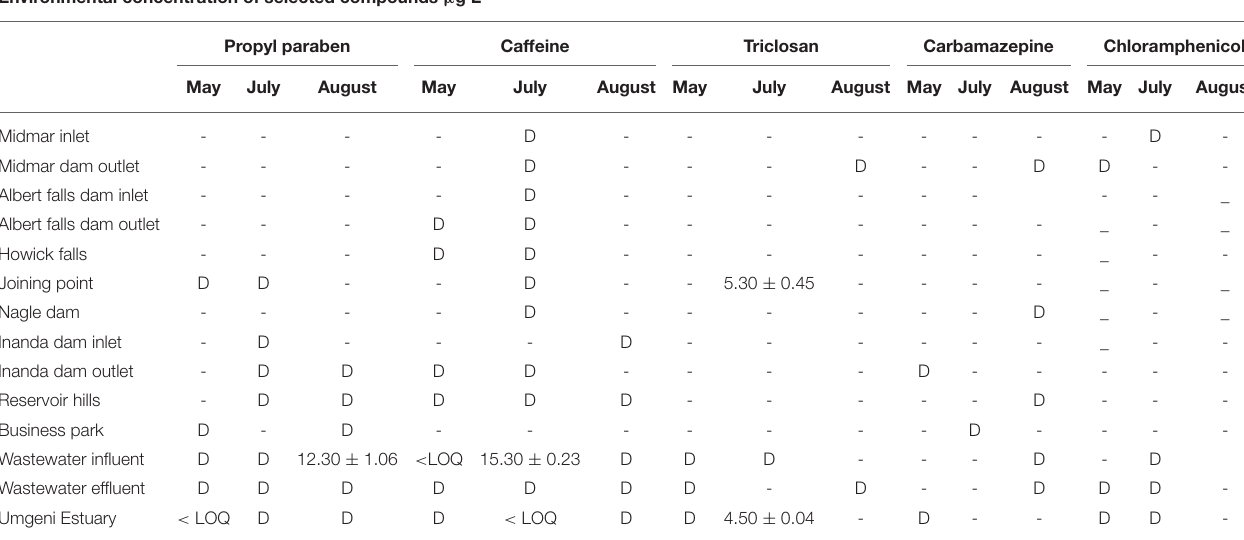
TABLE 5 | Concentration ( µ g L − 1 ) of personal care products and pharmaceuticals in fresh water and wastewater along the Mgeni river. Environmental concentration of selected compounds µ g L −